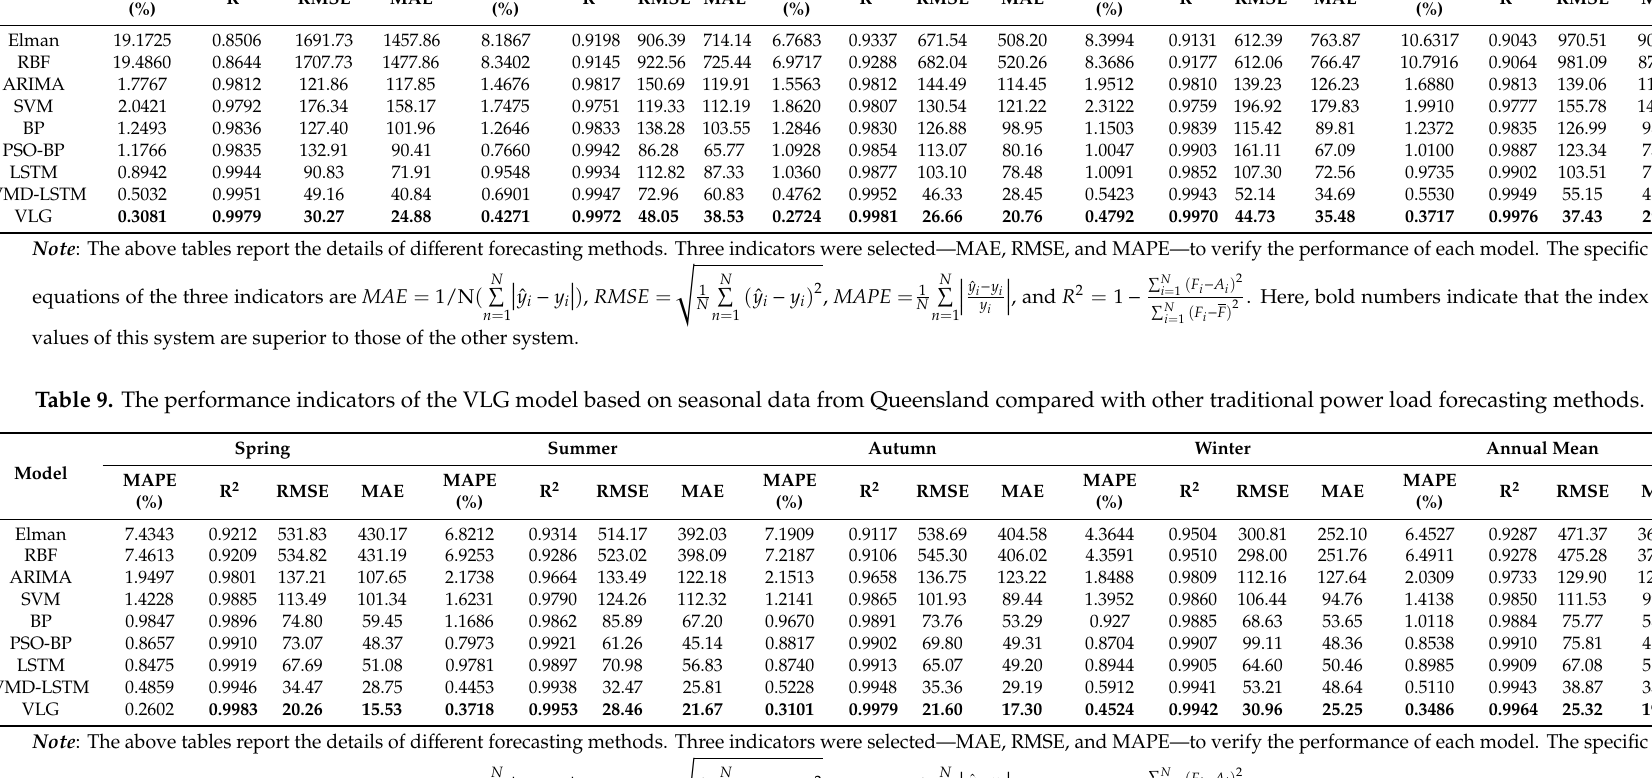
Table 8. The performance indicators of the VLG model based on seasonal data from New South Wales compared with other traditional power load forecasting methods. Spring Summer Model Elman RBF ARIMA SVM